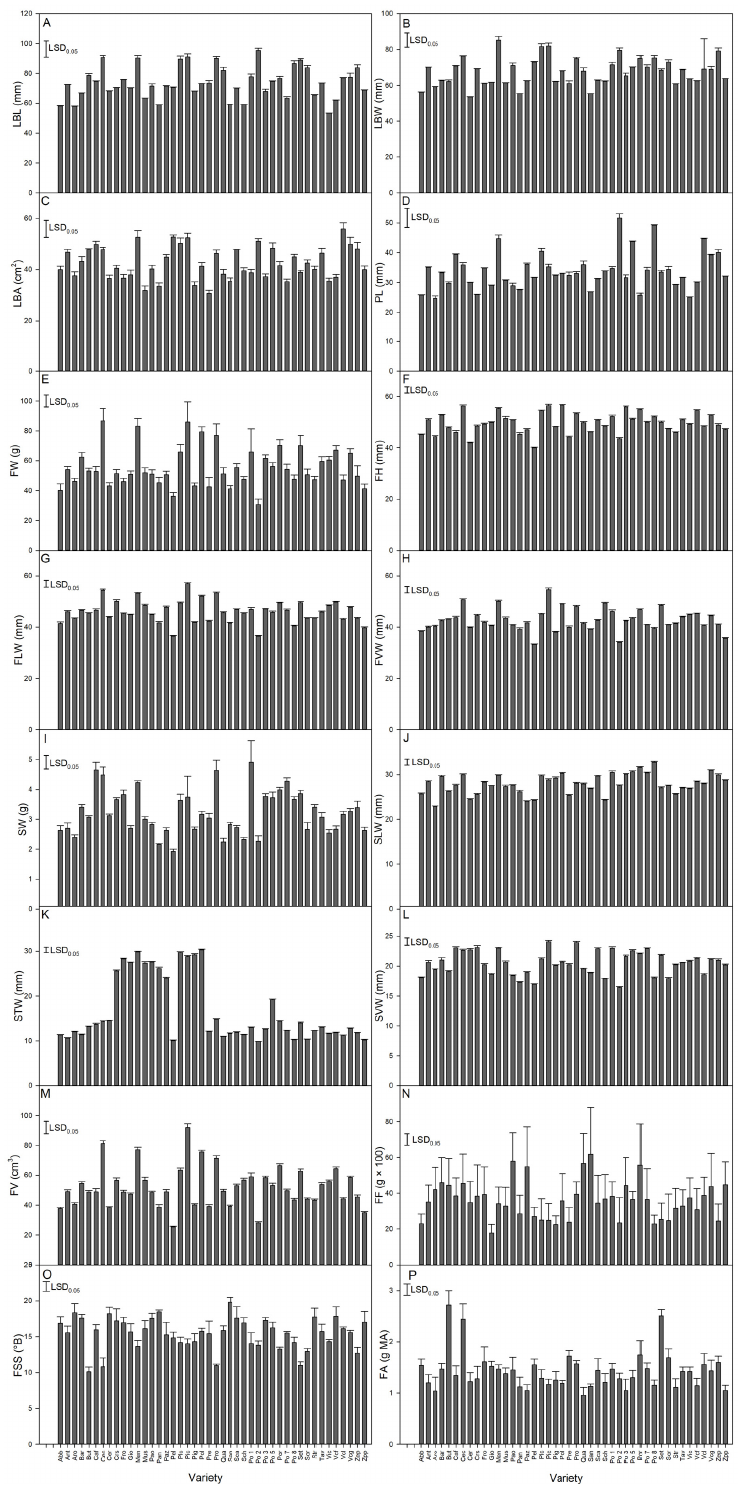
Figure 3. Histograms of the 16 quantitative traits scored in the apricot germplasm. For each trait, the graph reports the mean + standard error. The Least Significant Difference (LSD; one-way ANOVA, p < 0.05) is reported in the top left corner. ( A ) LBL: leaf blade length; ( B ) LBW: leaf blade width; ( C ) LBA: leaf blade area: ( D ) PL: leaf petiole length; ( E ) FW: fruit weight; ( F ) FH: fruit height; ( G ) FLW: fruit lateral width; ( H ) FVW: fruit ventral width; ( I ) SW: stone weight; ( J ) SLW: stone longitudinal width; ( K ) STW: stone transversal width; ( L ) SVW: stone ventral width; ( M ) FV: fruit volume; ( N ) FF: fruit firmness; ( O ) FSS: fruit solute soluble content; ( P ) FA: fruit